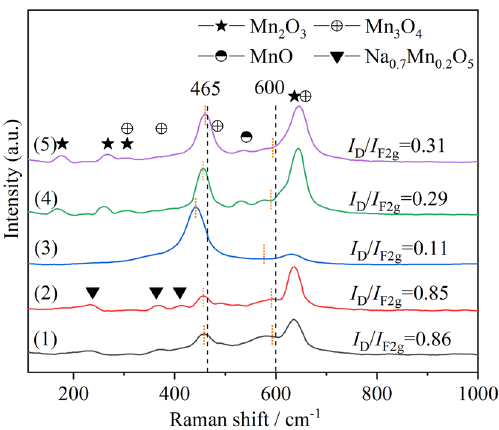
Figure 4. Raman spectra of cerium manganese catalysts: (1) CM-Na; (2) CM-NaC; (3) CM-NC; (4) CM-N; (5)